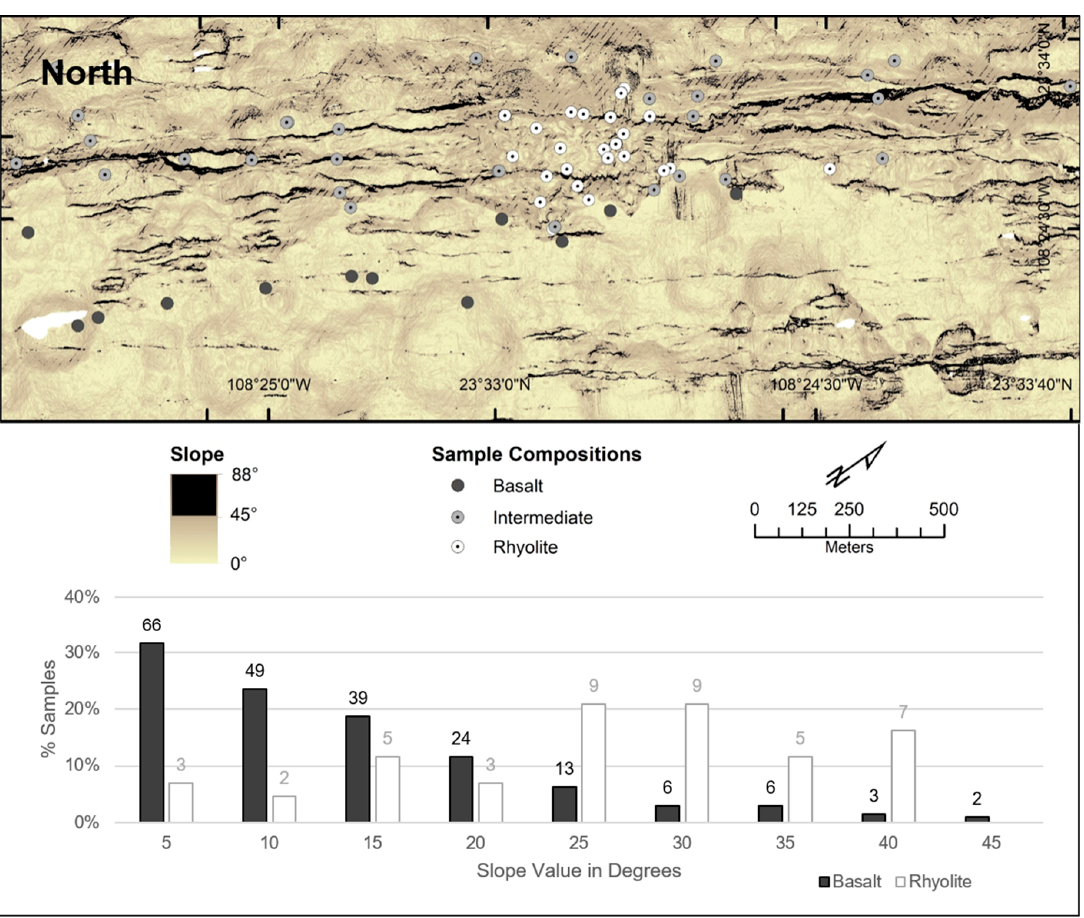
Figure 6. Slope (top panel) showing that rhyolites are associated with steep slopes, along with many intermediate compositions. Slope values >45° were only associated with faults and removed from the dataset used for lava morphology classification.